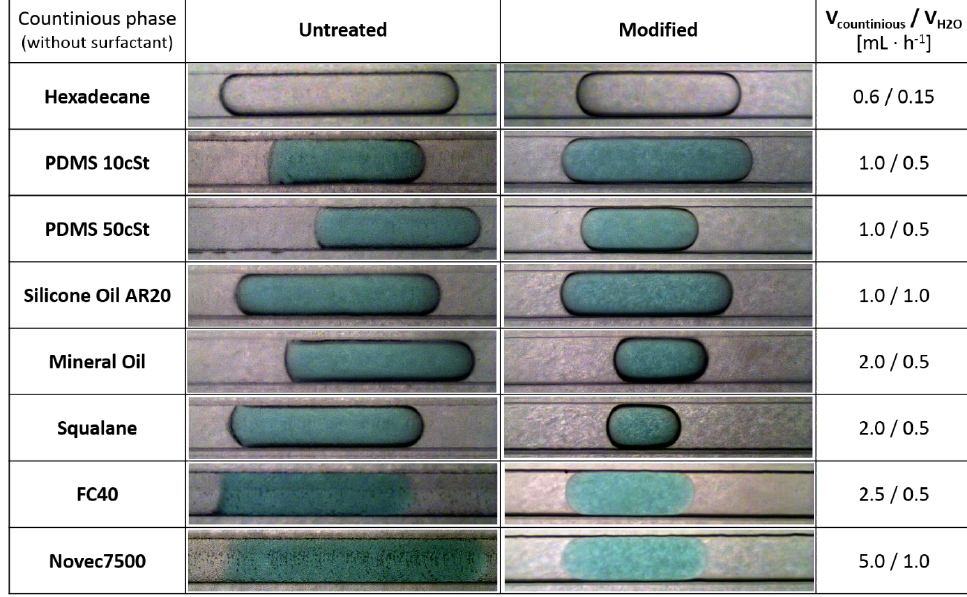
Figure 7. Result of the modification of PC in microchannels to elimination of wetting effect. Three milled walls and one native wall of microchannels were modified with the use of 20% NH 4 OH for 2 h with flow rate equals 6 mL h −1 .